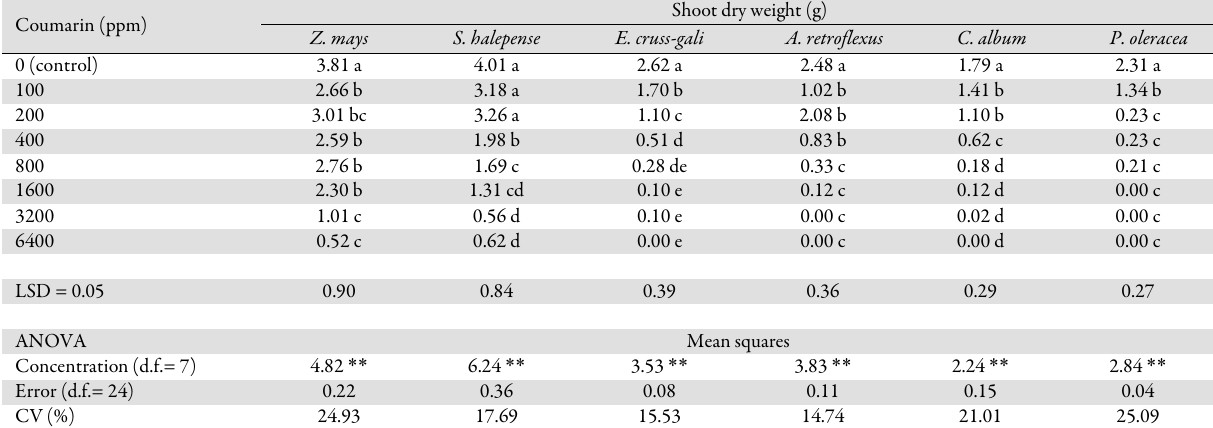
Shoot dry weight